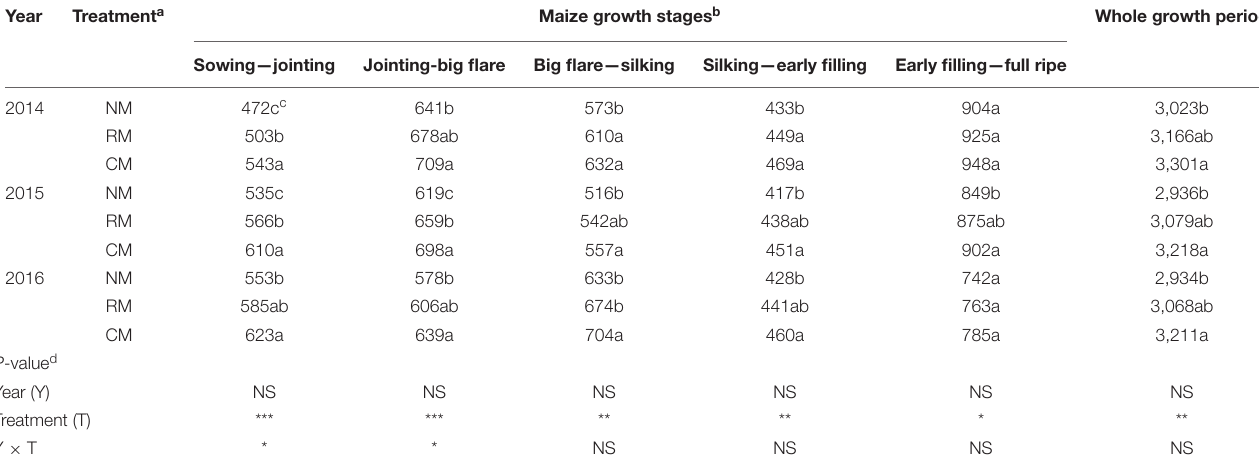
TABLE 3 | Soil accumulated temperature ( ◦ C) of each growth stage in maize with different plastic management practices from 2014 to 2016 in an arid oasis region. Year Treatment a Maize growth stages